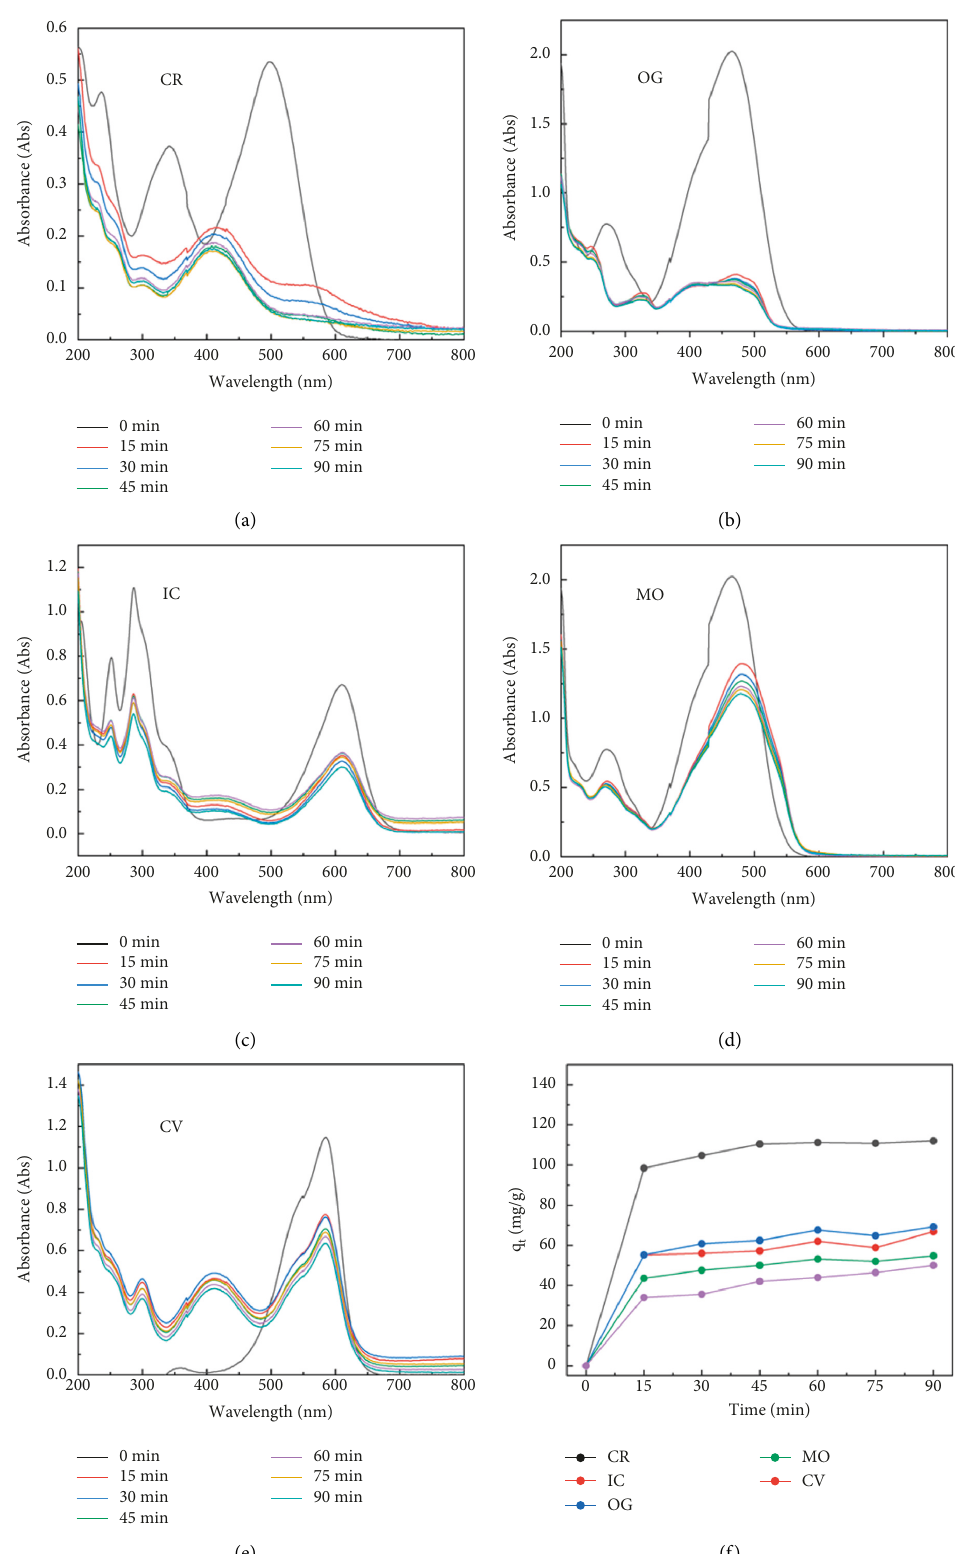
Figure 6: UV-Vis spectra of GluP adsorbent dispersed in aqueous solution collected at different time intervals, including (a) CR, (b) OG, (c) IC, (d) MO, and (e) CV. (f) The different adsorption capacity for five types of dye with GluP adsorbent at room temperature and pH 7 (0.25 g · L − 1 absorbent, 30mg · L − 1